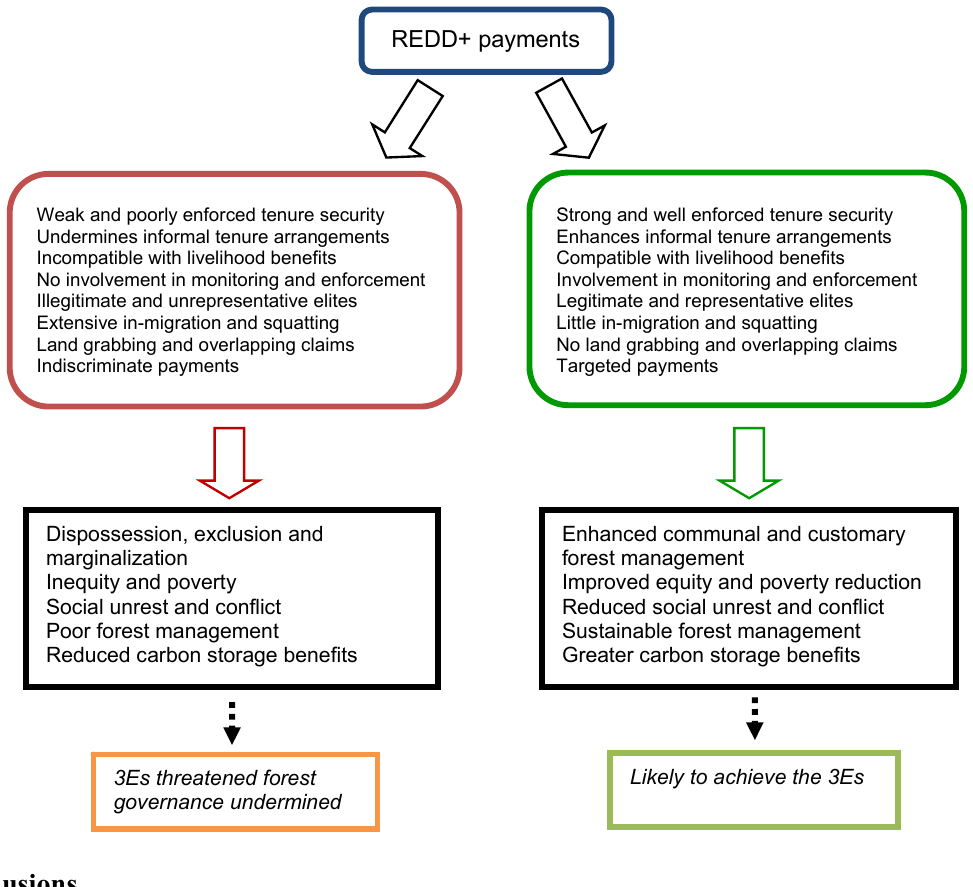
Figure 1. Conditions for success of REDD+ schemes on forest